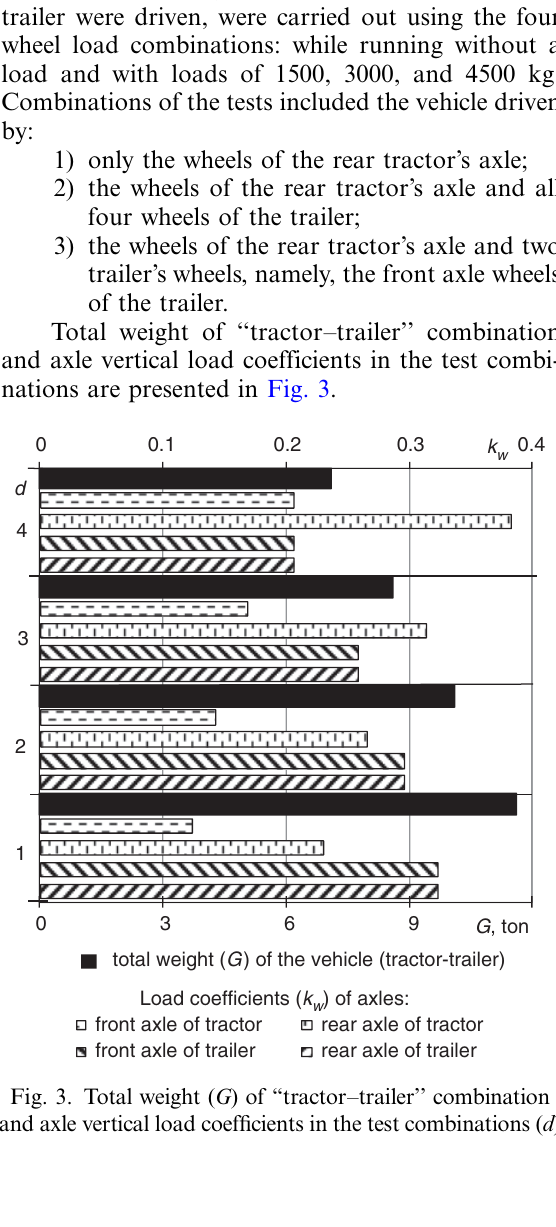
Fig. 3. Total weight ( G ) of ‘‘tractor (cid:2) trailer’’ combination and axle vertical load coefficients in the test combinations ( d )